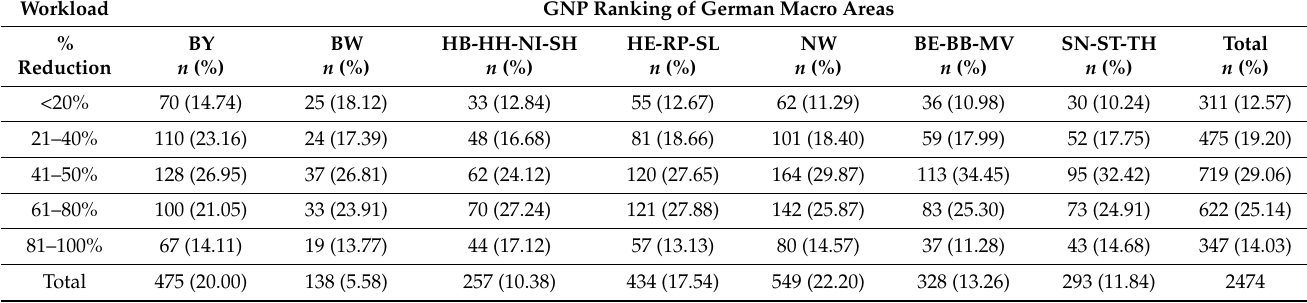
Table 2. Weekly workload reduction during the lockdown period among the German macro areas ranked by Gross National Product (GNP).